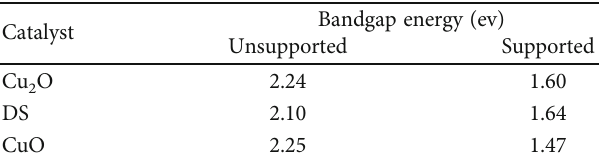
Table 4: Bibliographic experimental data for rhodamine B photodegradation. Photocatalyst particles